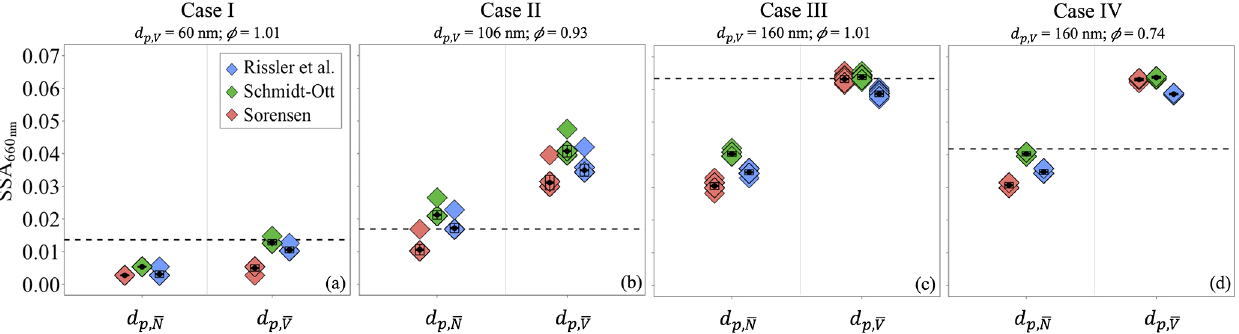
Figure 4. Modelled single-scattering albedo (SSA) of bare BC aggregates using the three methods for calculation of the primary particle number (Rissler et al., 2012; Sorensen, 2011; Schmidt-Ott, 1988). Panels (a) – (d) show the results for the four cases of E1. For each case, the three methods were applied to calculate the N pp using both the d and d ( x axis). The mean of the modelled SSA for each method is p ,N p ,V shown by the black point. The dashed line in the panels represents the mean of the experimentally measured SSA.